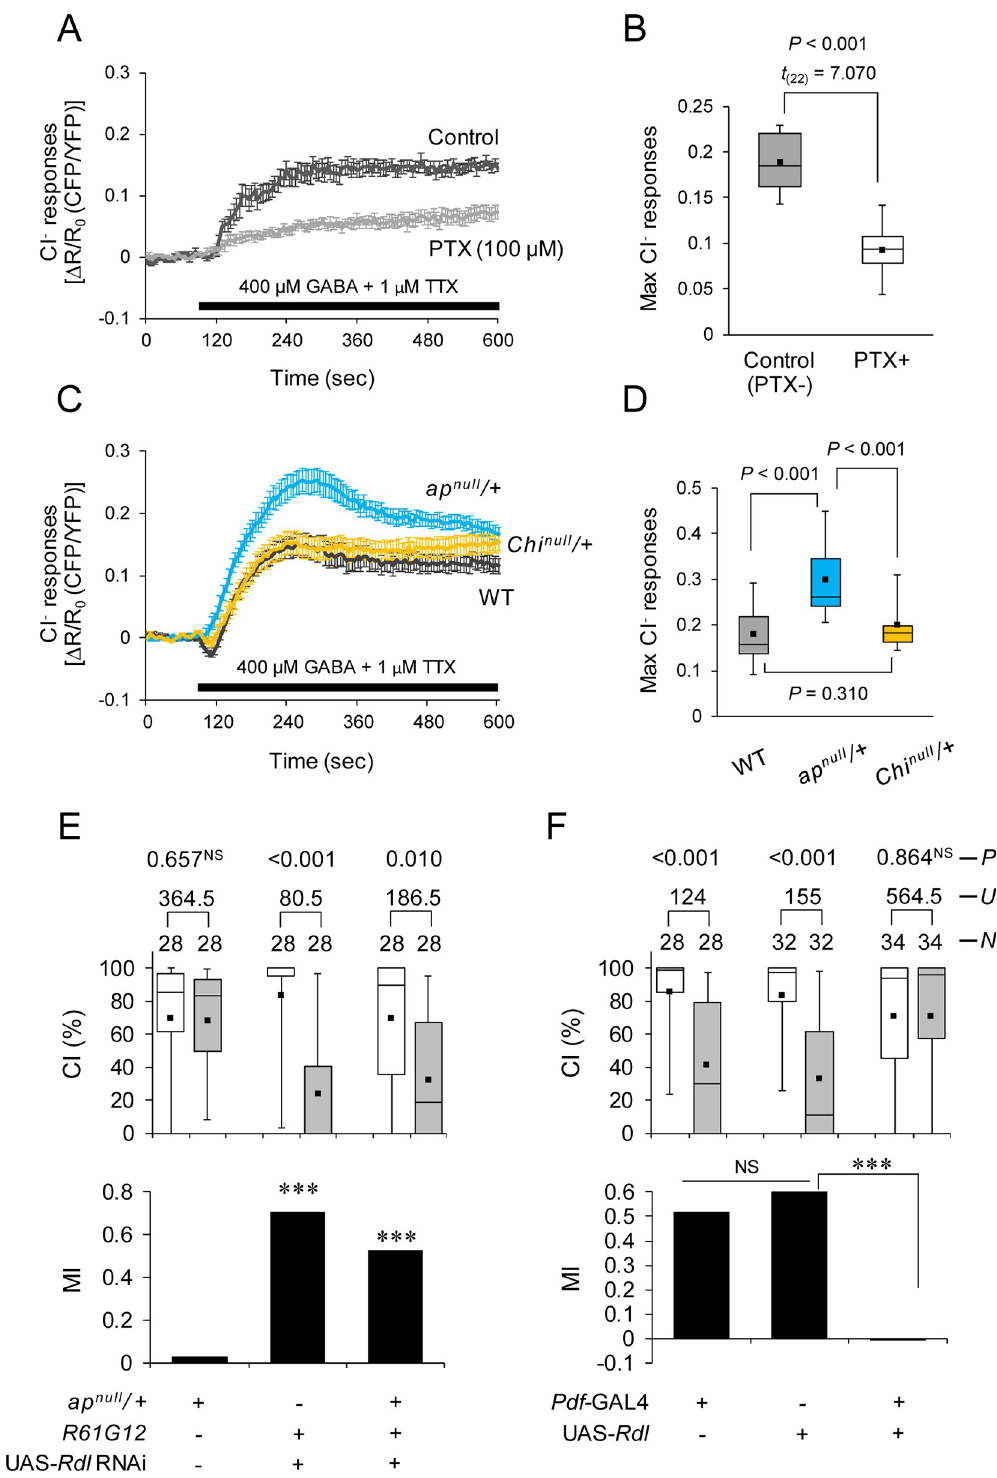
Fig 9. Ap in l-LNvs is indispensable for appropriate response to GABA. The underlying data can be found in S1 Data. (A– D) Ex vivo imaging using SuperClomeleon. (A and B) UAS- SuperClomeleon / R61G12 flies were used. PTX, picrotoxin. (A) Traces of mean SuperClomeleon response to 400 μ M GABA and 1 μ M TTX with or without bath-applied 100 μ M PTX. Error bars, SE; N = 12 in each trace. (B) Maximum percentage change in fluorescence of SuperClomeleon related to (A). Student